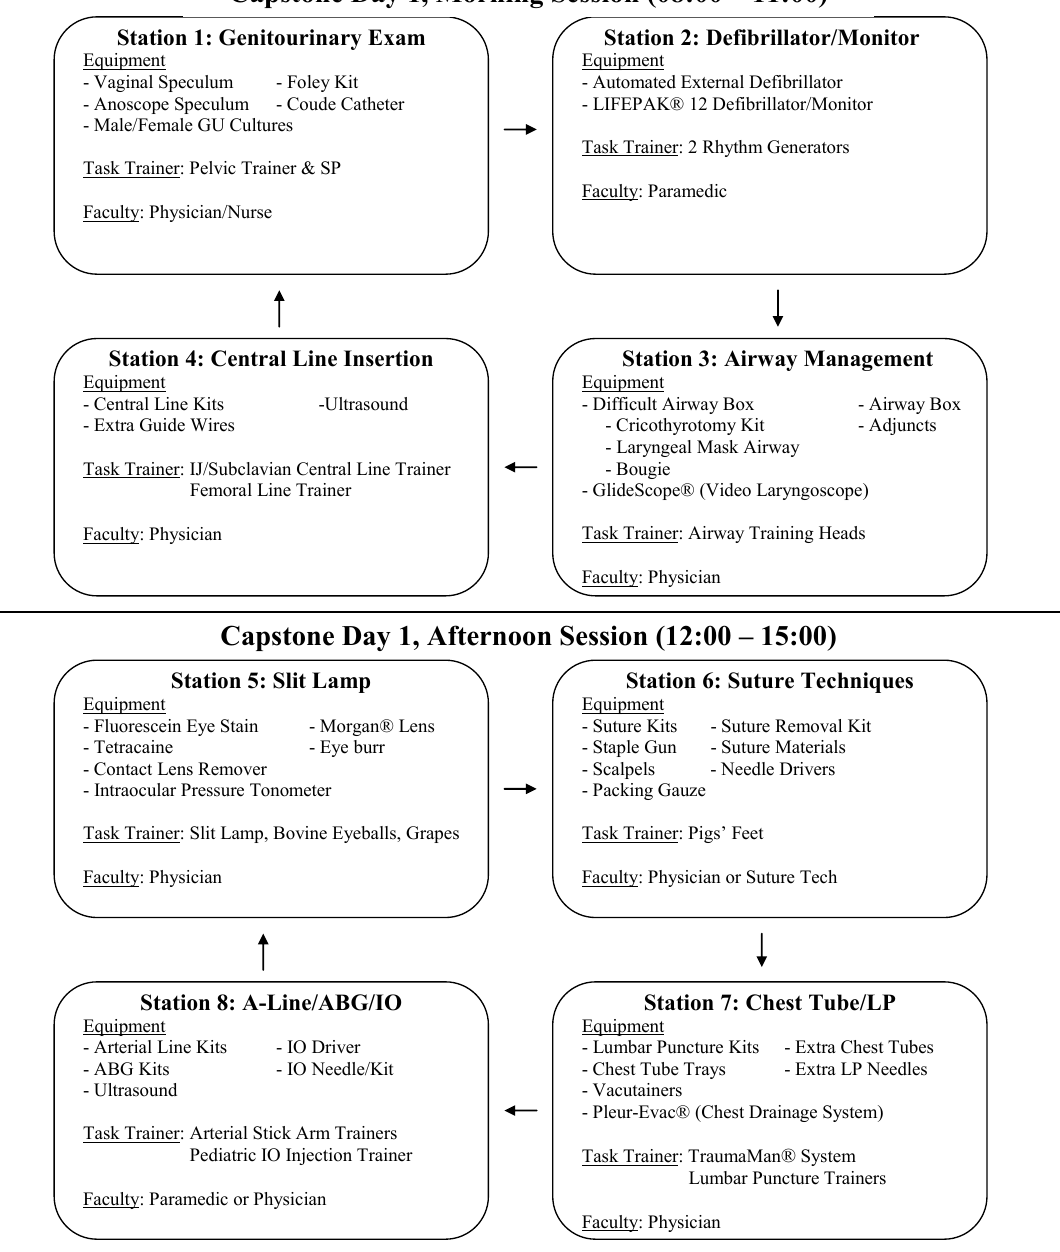
Figure 2. Skill stations and required equipment for capstone experience day